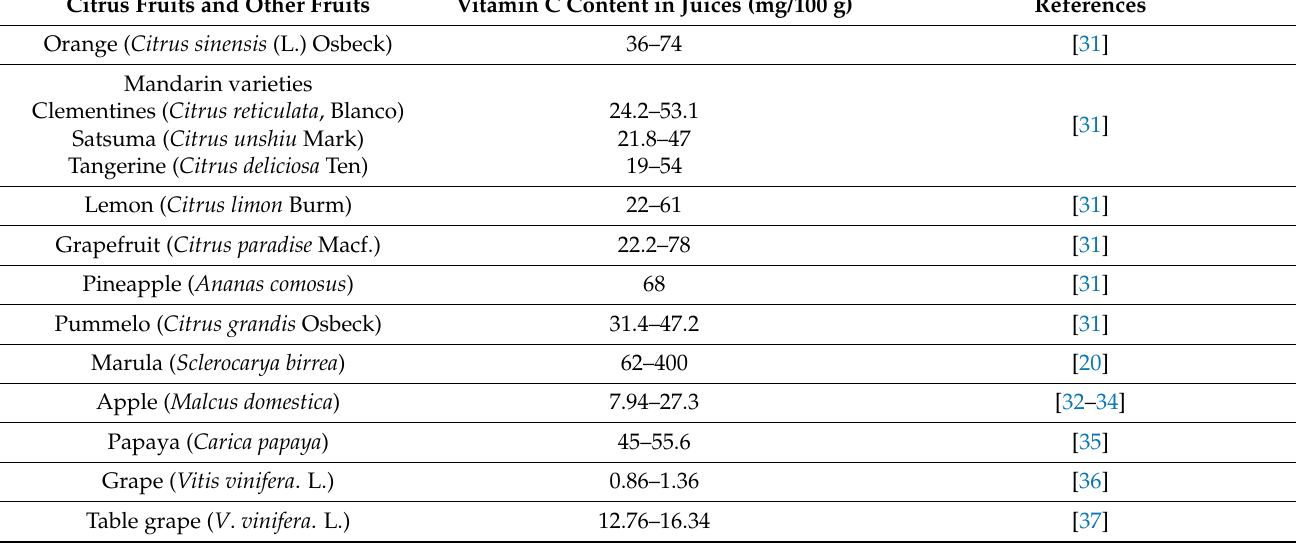
Table grape ( V . vinifera .